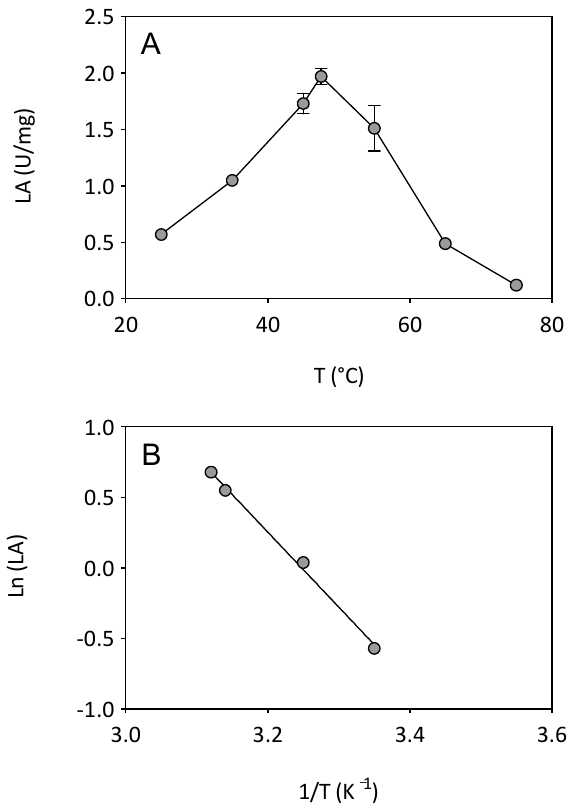
Figure 1. Temperature effect on the activity of KLEST-3S. ( A ) Enzymatic activities were determined with 2.5 mM pNP C12 at pH 8.0 at the different assayed temperatures. ( B ) Arrhenius plot of temperature dependence. The logarithm of the enzyme activity (units/mg) is plotted against the reciprocal of absolute temperature, T.